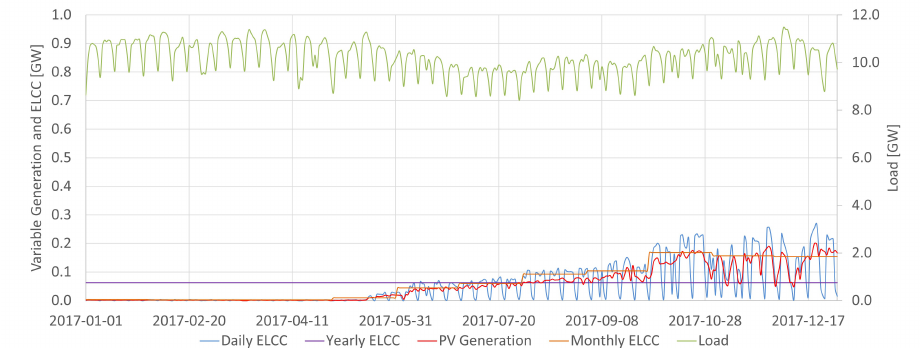
Figure 15. Daily, monthly and yearly ELCC for PV power in 2017 for the Northeast subsystem.